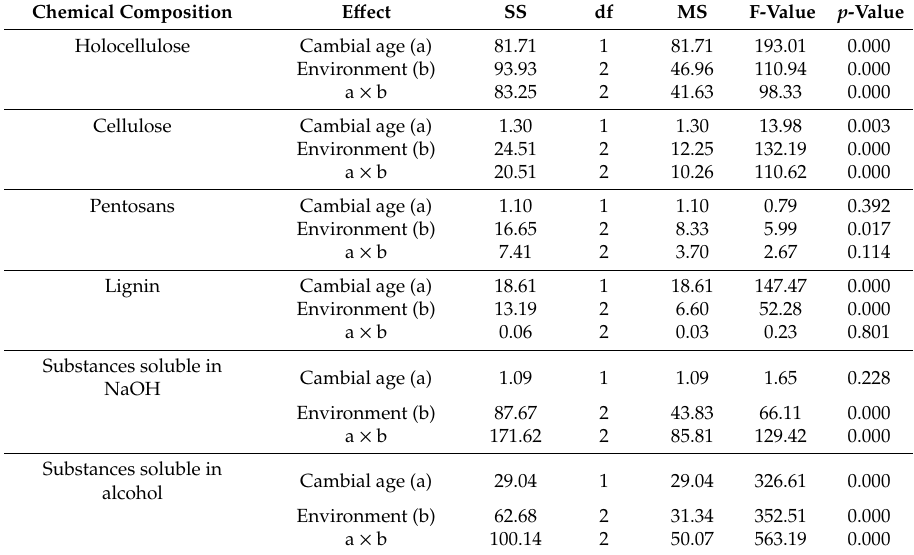
Table 1. Two-factor analysis of variance (ANOVA) tables for chemical composition of lime ( Tilia cordata Mill.) wood taking into account the e ff ect of cambial age and environment.